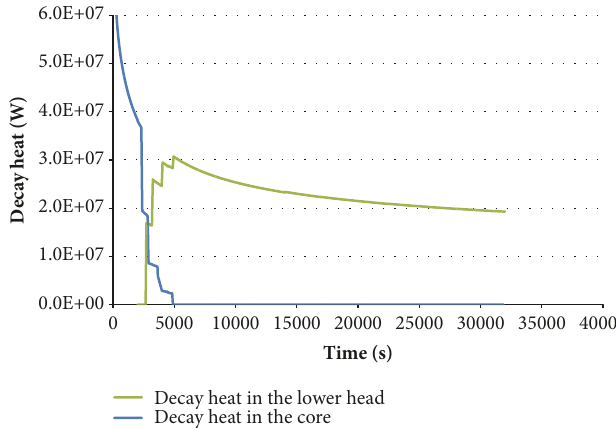
Figure 10: Decay heat in the reactor core and the corium in the lower head.